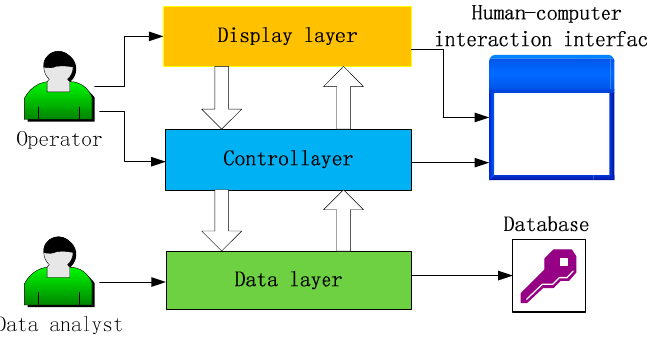
Figure 8. Structure chart of the measurement system software.